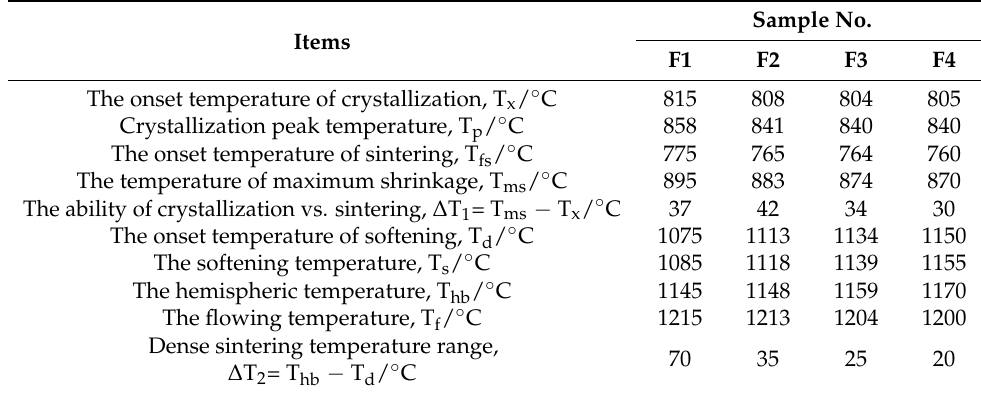
Table 4. Characteristic temperatures for samples F1–F4.